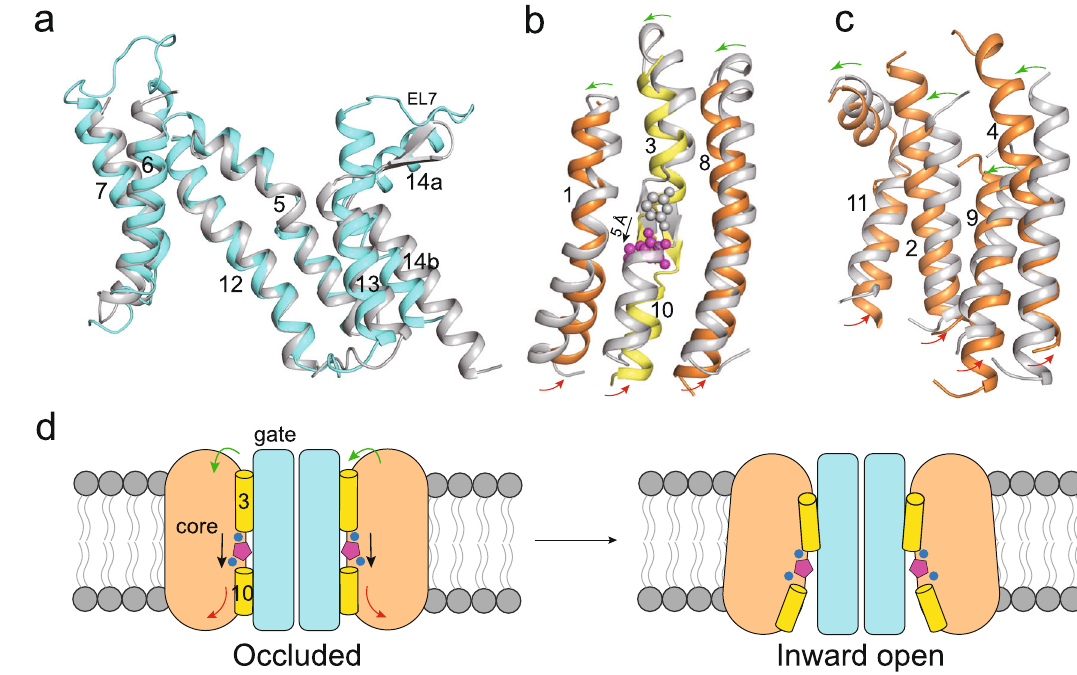
Fig. 4 | Transport mechanism of MmSVCT1. a Structural comparison of the gate domain between inward-open MmSVCT1 (cyan) and occluded UraA (gray). b , c Movements of the core domain of the inward-open MmSVCT1 (orange or yellow) and occluded UraA (gray) viewed from the gate domain. Vitamin C and uracil are shown as purple and gray spheres, respectively. The directions of